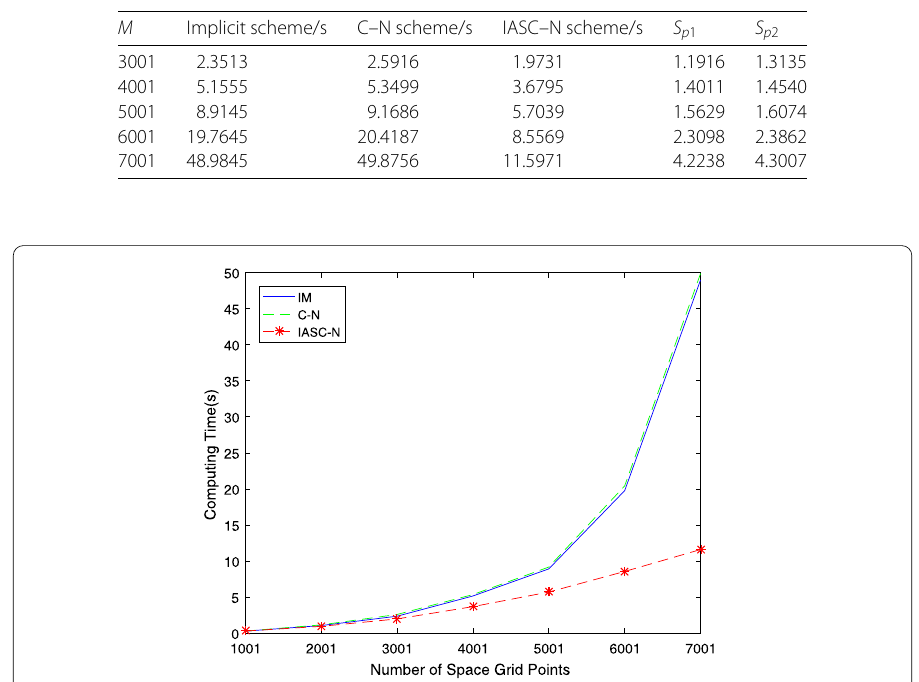
Figure 9 Comparison of computing time between the three schemes ( α =